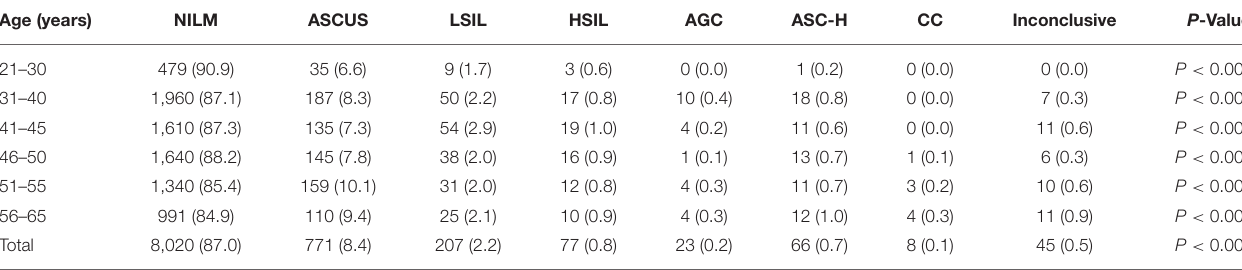
TABLE 5 | Detection of cytological abnormalities according to age group, N (%).